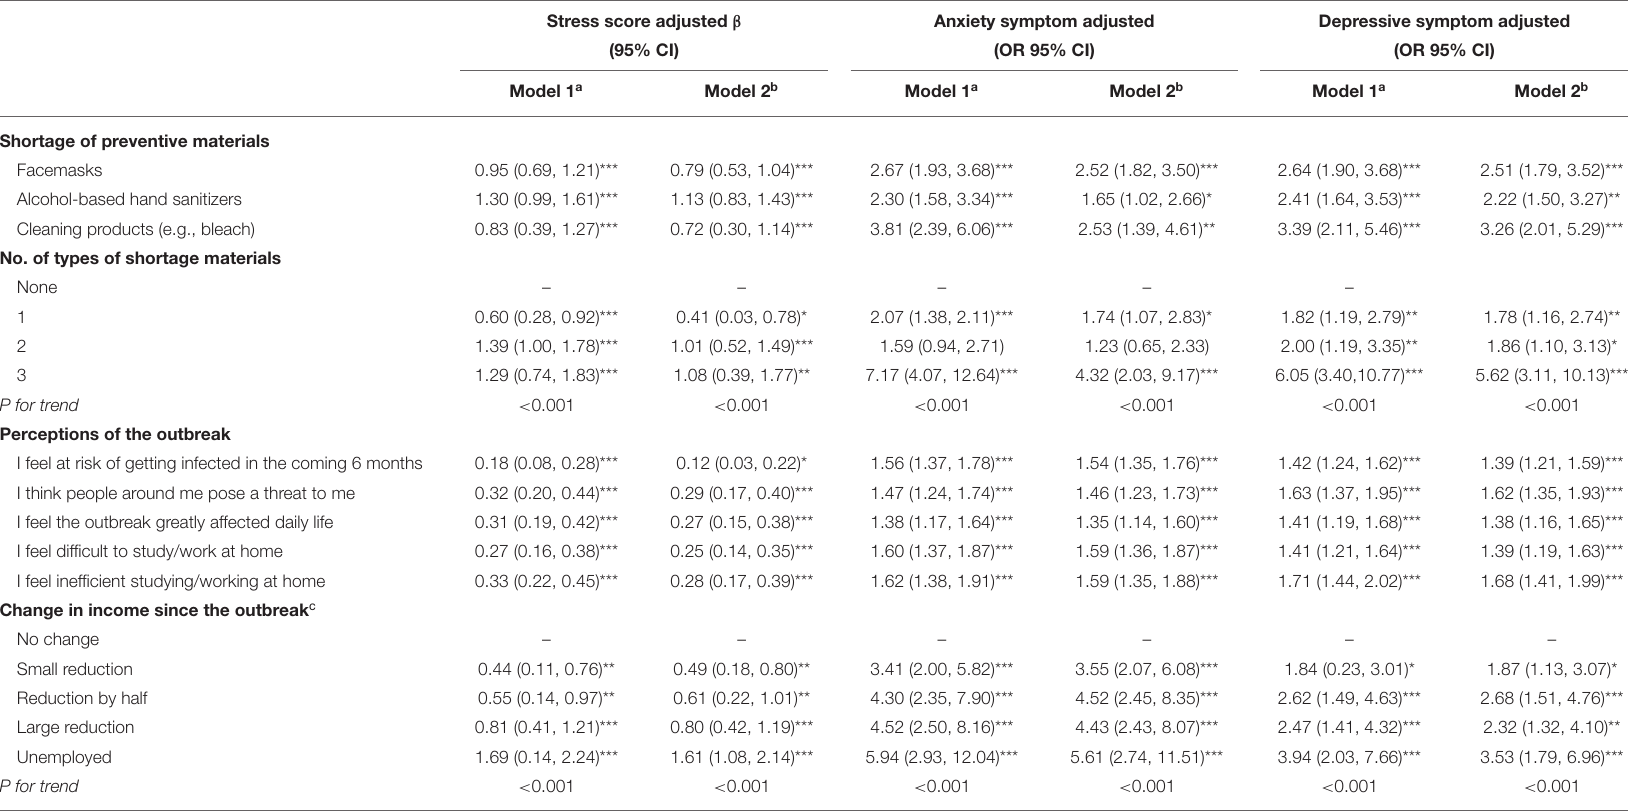
OR, odds ratio. P for trend: test of the dose–response effect in the association. a Regression model 1: adjusted for sociodemographic variables including sex, age, and education attainment. b Regression model 2: additionally adjusted for self-rated health, chronic disease, smoking, and alcohol drinking. c Excluded students, homemakers, and